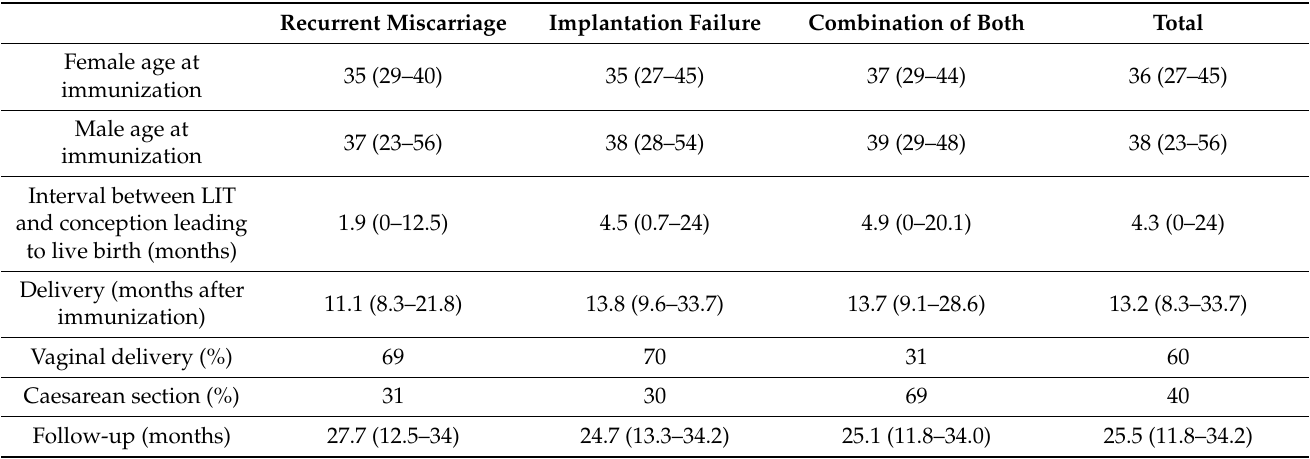
Table 1. Patient